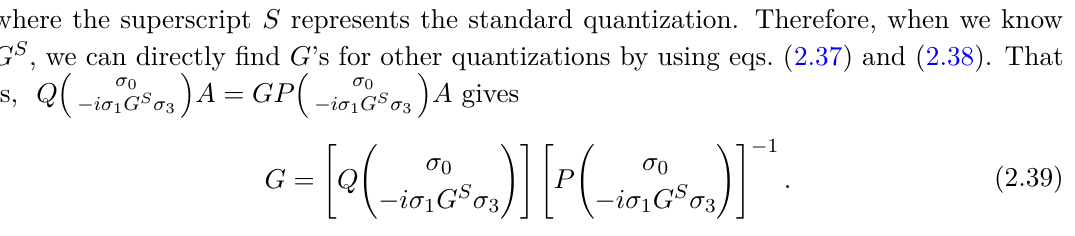
Figure 2 . Holographic spectral functions for different boundary actions S bdy = R Γ = i I 4 , Γ xy , Γ 5j with j = x, y . ± S bdy give essentially the same results with k y ↔ − k y